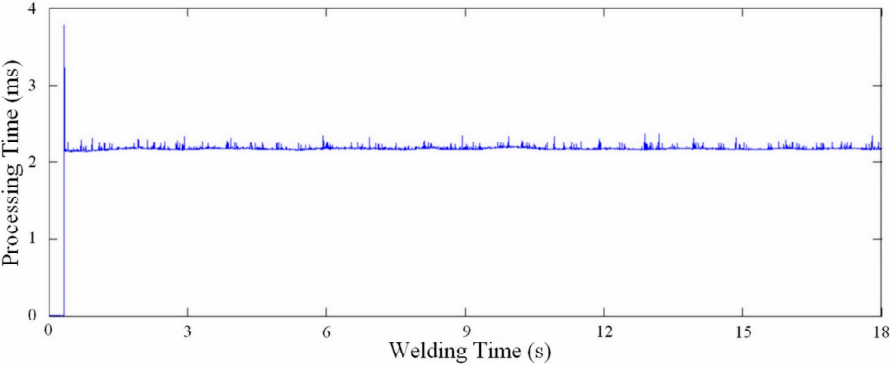
Figure 17. Processing time for each acquired image in the work point 21 V and 6 m/min [22].